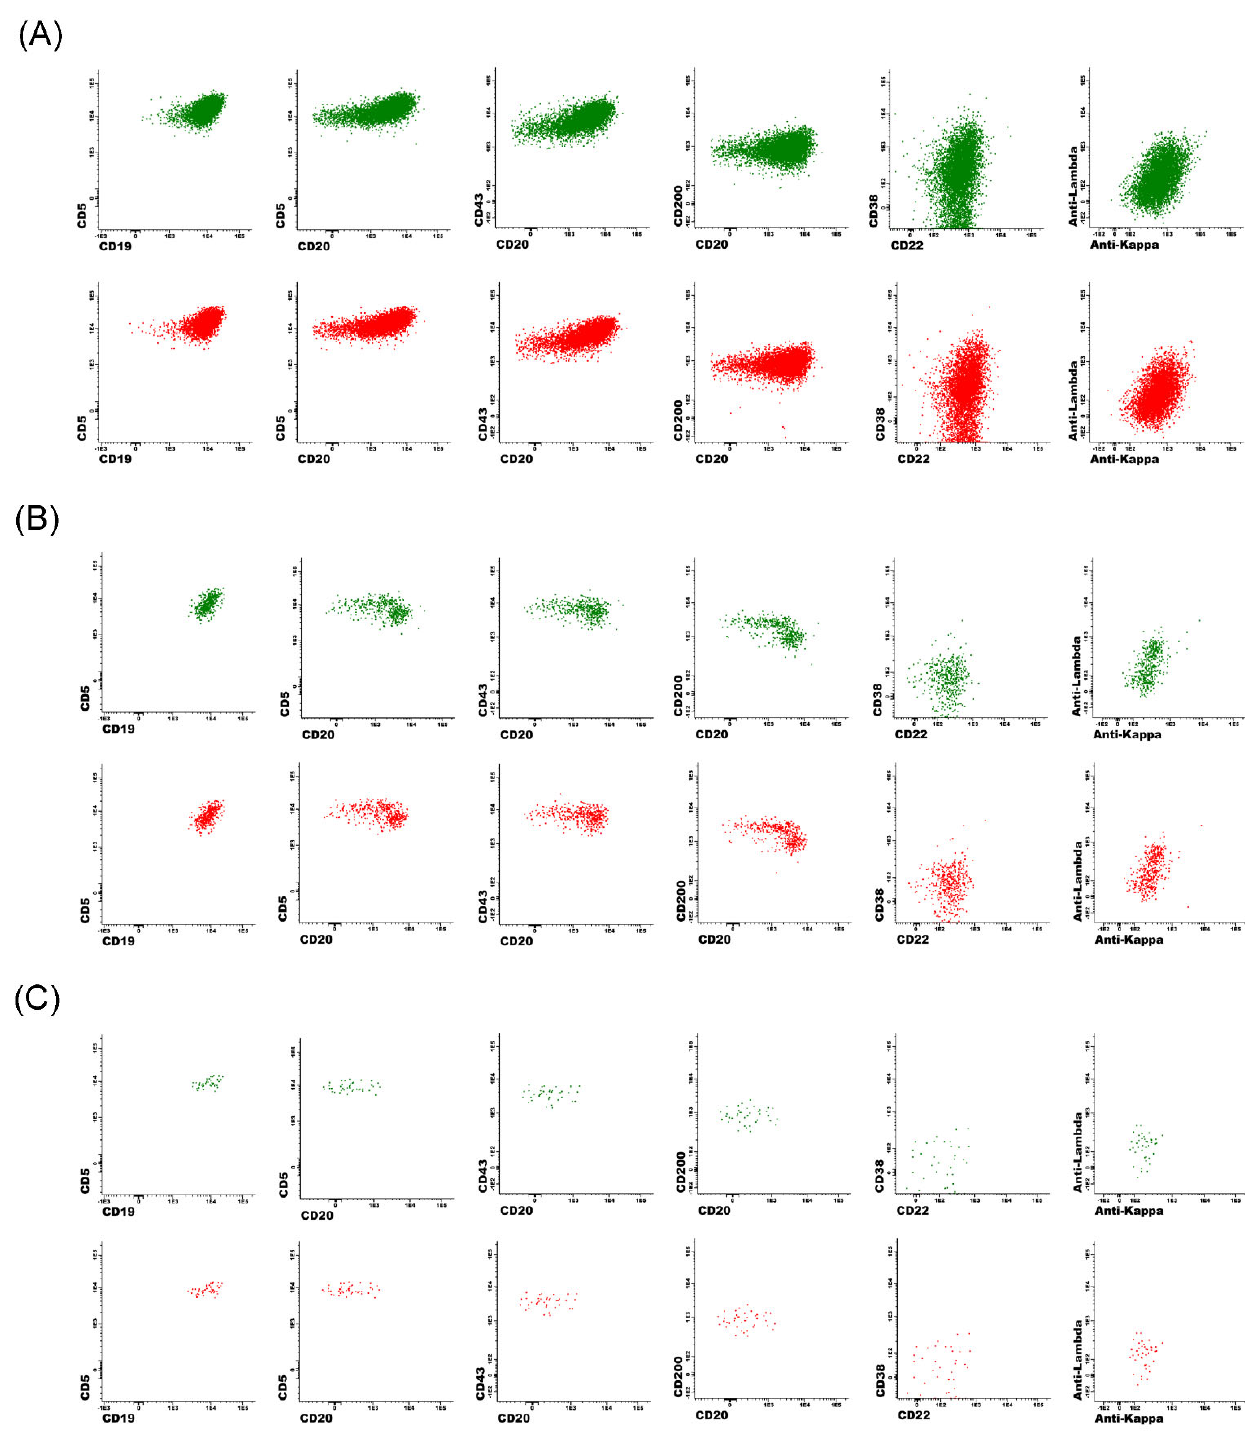
Figure 5. Side-by-side comparison of 2D dot plots show expert-gated CLL populations (green) and DNN-gated CLL populations (red) in three representative cases, using common marker combination. ( A ) 6076 expert-gated CLL events with a MRD level at 0.76% and 5147 DNN-gated CLL events with a MRD level at 0.73%. ( B ) 449 expert-gated CLL events with a MRD level at 0.026% and 424 DNN-gated CLL events with a MRD level at 0.031%. ( C ) 41 expert-gated CLL events with a MRD level at 0.0030% and 42 DNN-gated CLL events with a MRD level at 0.0035%.